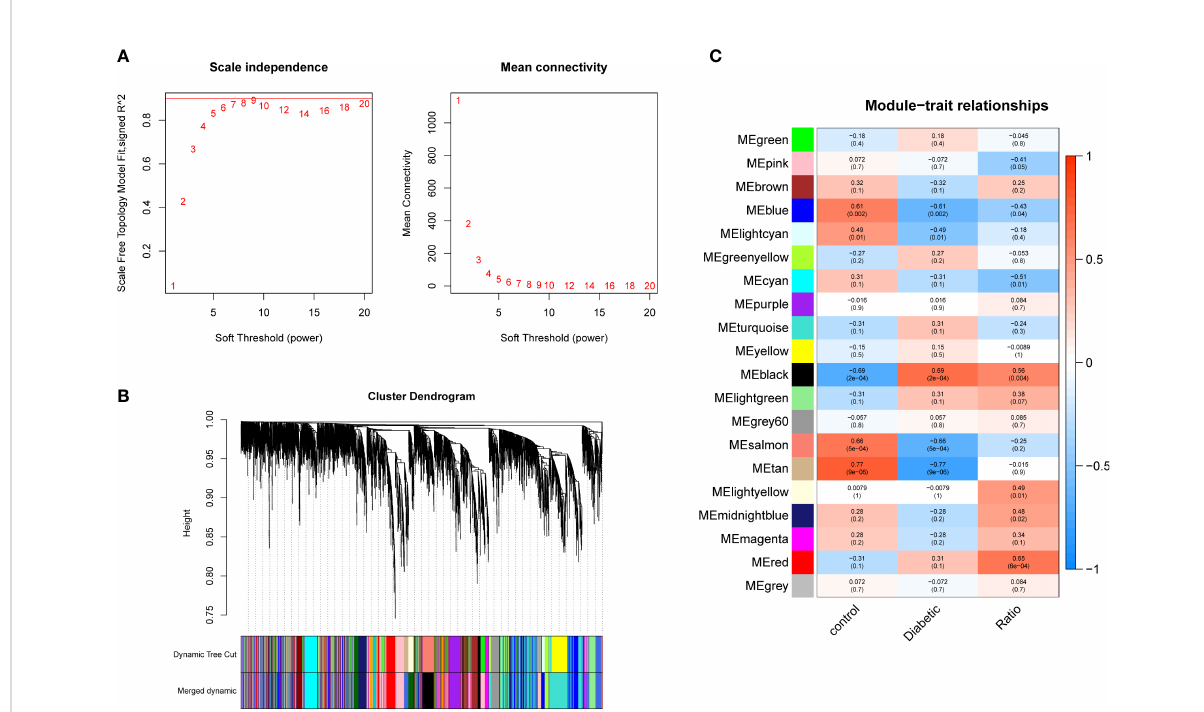
FIGURE 2 Gene co-expression modules. (A) Analysis of network topology for soft-thresholding powers. (B) Hierarchical cluster dendrogram of DCM- related genes based on one dissimilarity measure. (C) Module-phenotype